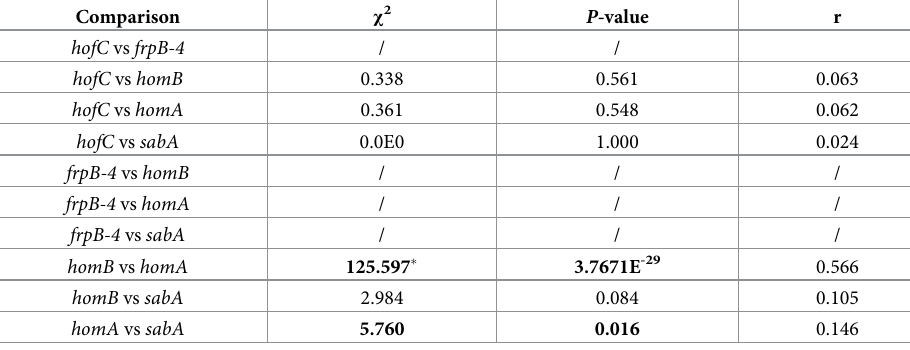
Table 4. Comparison and statistical analysis of H . pylori OMP